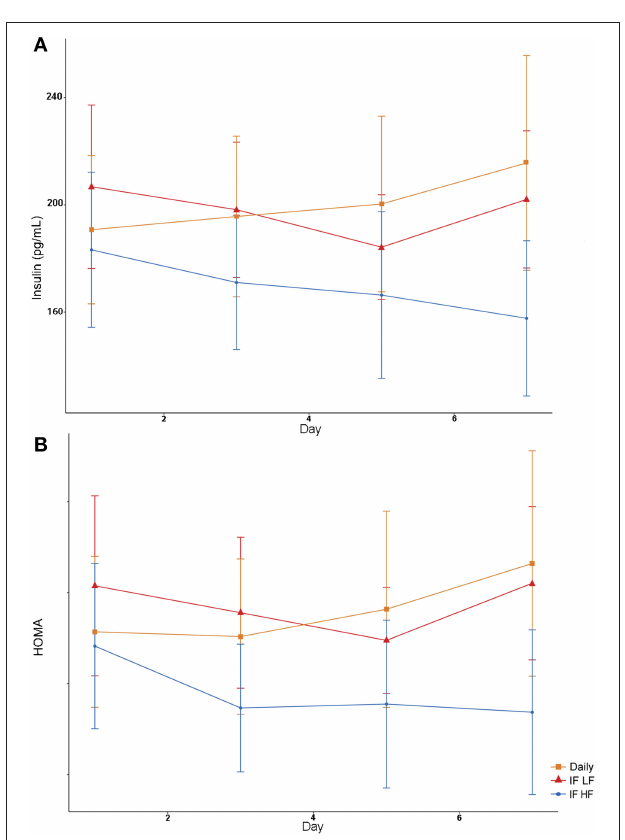
FIGURE 8 | Mean concentrations ( ± SE) of fasted serum insulin (A) and HOMA score (B) in 10 dogs fed daily (square), and intermittently fasted on a low fat (triangle) and a high fat diet (circle) in a Latin Square design.